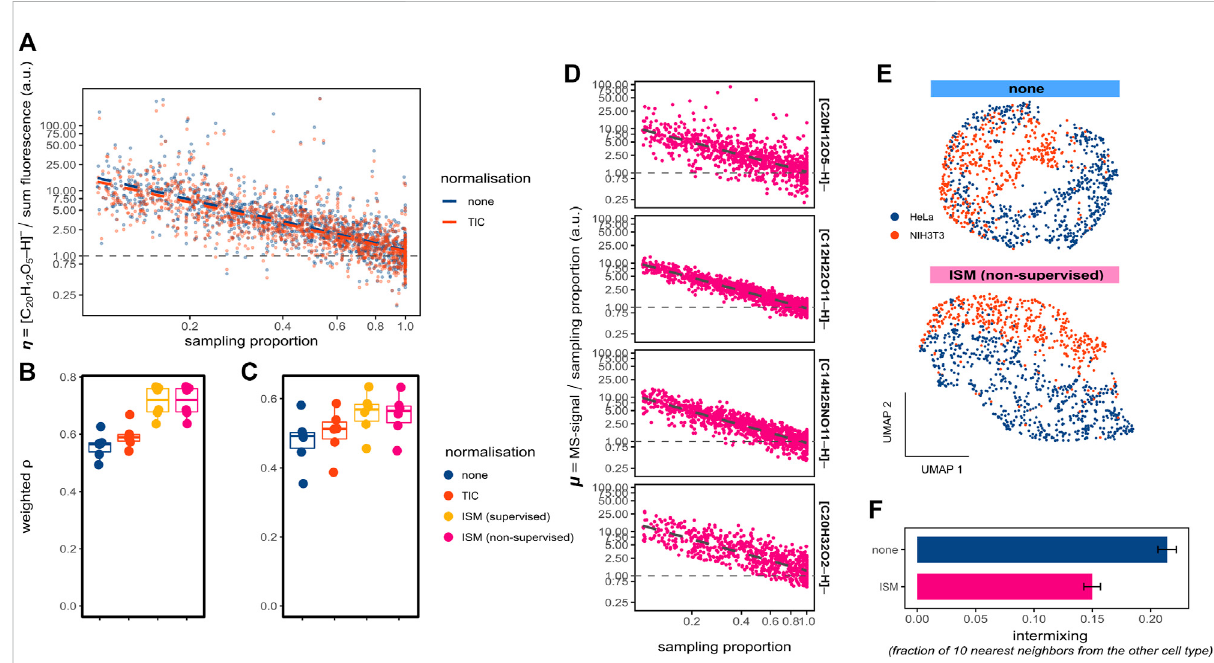
FIGURE 2 Compensating for ion suppression in spatial single-cell metabolomics. (A) Representative scatter plot for ablated regions (belonging to one replicate),plottingthescaledratio η ( fl uoresceinion[M-H] - intensitydividedbythe fl uorescence)againsttheablatedregionsamplingproportion;the ratios η are setto 1 for sampling proportions of 1; using TIC-normalised (red) and unnormalized(blue) MS intensities; both axes are log-transformed. (B,C) Boxplots with density-weighted Spearman correlations between fl uorescence and MS intensities of fl uorescein for either ablated regions (B) or cells (C) using the WA method (sampling proportion of 0.3, m/z tolerance 4 ppm) for 6 replicates, with different normalisation methods including the supervised and unsupervised ion suppression method (ISM). (D) Representative scatter plots of the ratio μ plotted against the sampling proportion for four ions [(C 20 H 12 O 5 -H) - corresponding to fl uorescein, (C 12 H 22 O 11 -H) - for a disaccharide, (C 14 H 25 NO 11 -H) - for a polysaccharide, and (C 20 H 32 O 2 -H) - forarachidonicacid];ratiosaresetto1forsamplingproportionsof1;bothaxesarelog-transformed. (E) UMAPvisualisationofsingle- cellmetabolomicsdataobtainedfromaco-cultureofHeLa(blue)andNIH3T3(red)cells(Rappezetal.,2021).CellswereWA-normalisedwith(upper panel)orwithout(bottompanel)applyingtheunsupervisedmethodforcompensatingtheionsuppression(ISM). (F) Quanti fi cationoftheintermixing betweenthecelltypesfrompanelE,withbarplotsshowingthemeanandstandarddeviationofthemeanfractionsofallcell ’ s10nearest-neighbours with the opposite cell type, per normalisation